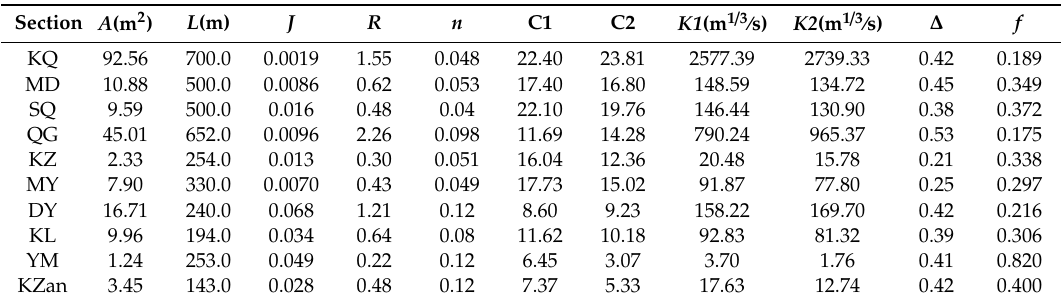
Table 5. Parameter values of study sections. (Note: A = area; L = length of vertical section; J = hydraulic gradient; R = hydraulic radius; n = roughness; C 1 and C 2 = Chezy’s coe ffi cient; K 1 and K 2 = discharge modulus; ∆ = equivalent roughness; f = roughness coe ffi cient).